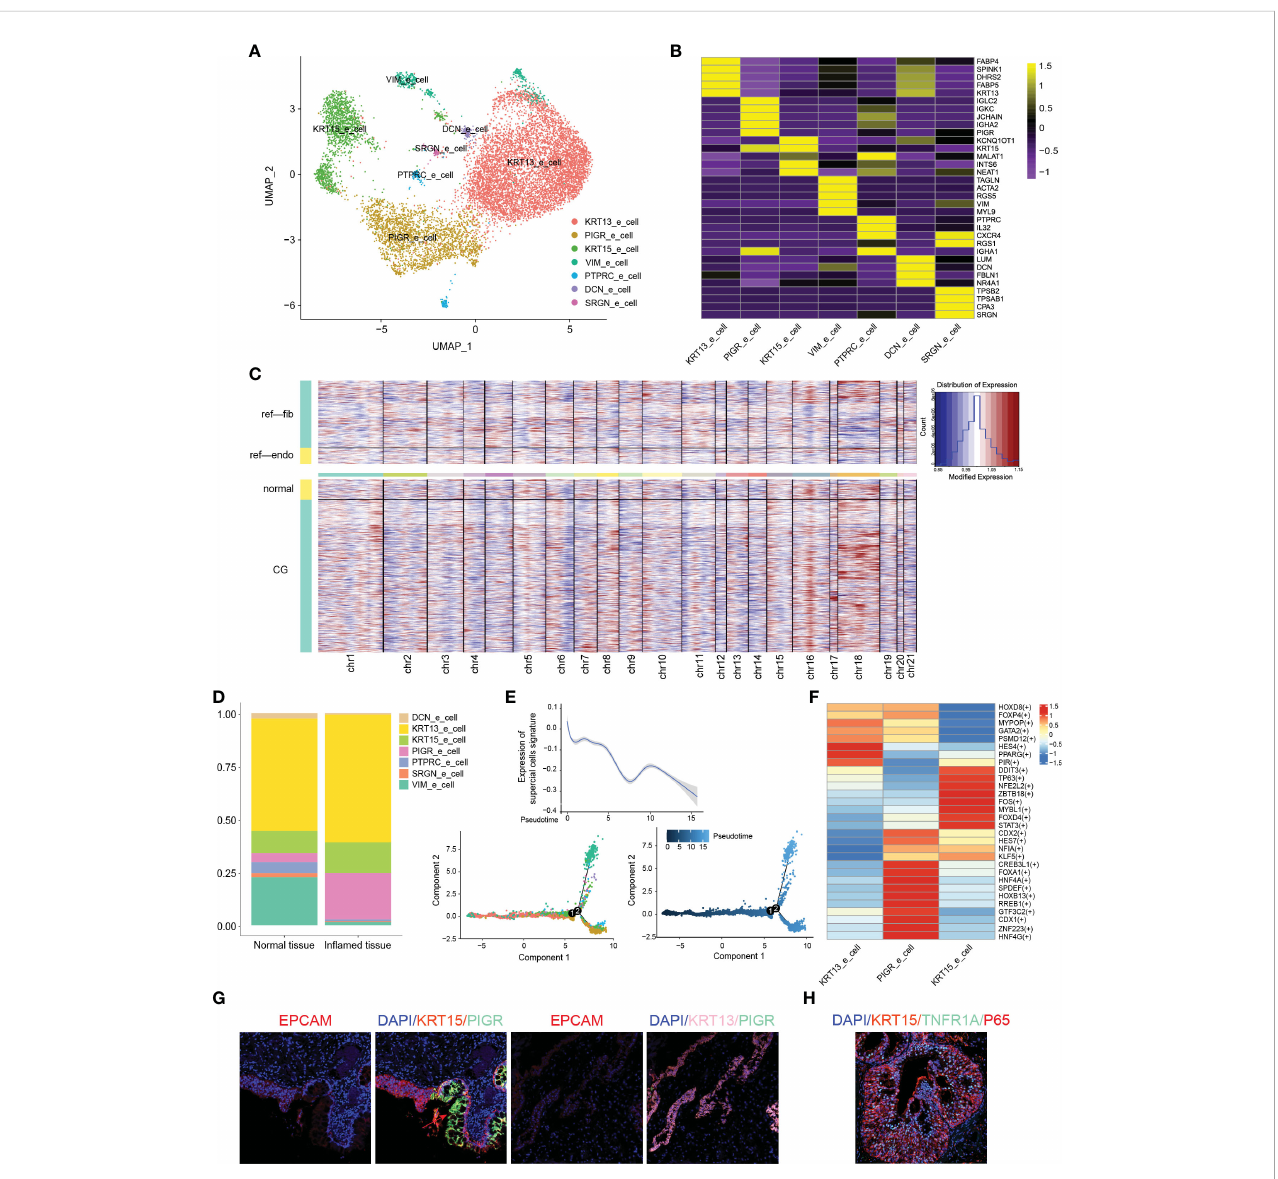
FIGURE 2 Classi fi cationandanalysisof epithelial cellsincystitisglandularis. (A) U-MAPplotof differentsubsetsofepithelial cellscorrelatedby color. (B) Heatmapshowing Top5-speci fi cgenes expressedinepithelial cellsubsets. (C) InferCNVwasusedtoestimatethecopy numbervariationscoreofepithelial cells,inwhichCGand normal bladdermucosawerecomparedtoendothelialcells and fi broblasts. (D) Theproportionofdifferentkindsofepithelial subsetsamongall epithelial cells. The leftpanelindicatesnormal tissue andtherightpanel indicatesin fl amedtissue. (E) Pseudotimetrajectoryof epithelial cellsof allsamplesinferredby Monocle2. Bottom: (left)pseudotimetrajectory of epithelialcell subsetsmarkedbycolor,and (right)thechronologicalorderof developmentmarkedbycolor depth.Top: Change curve of theoverall expressioncontentofthesuper fi cial epithelialcell markergenesetbasedonthepseudotimetrajectory of epithelialcell subsets. (F) Heat mapshowingtheexpression of majortranscriptionfactors inepithelial cell subsetsusingSCENIC. (G) Multiplex immuno fl uorescenceveri fi edvariouskindsof epithelial cell in fi ltration. (H) TNF-P65in fl ammatory activationinKRT15epithelial